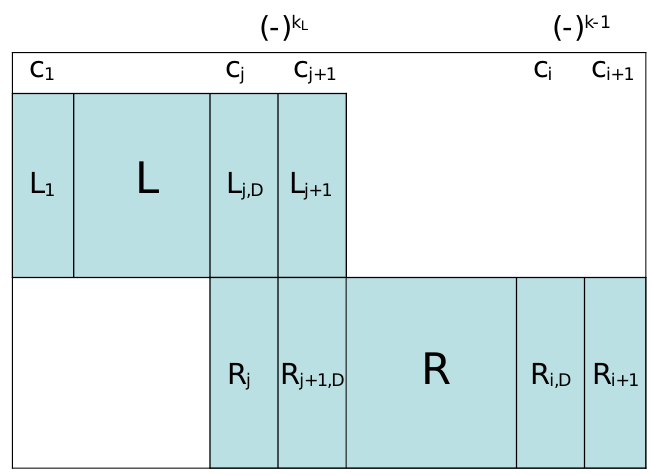
Figure 9 . Generic matrix con(cid:12)guration of tree BCFW recursion relation labelled by i; j